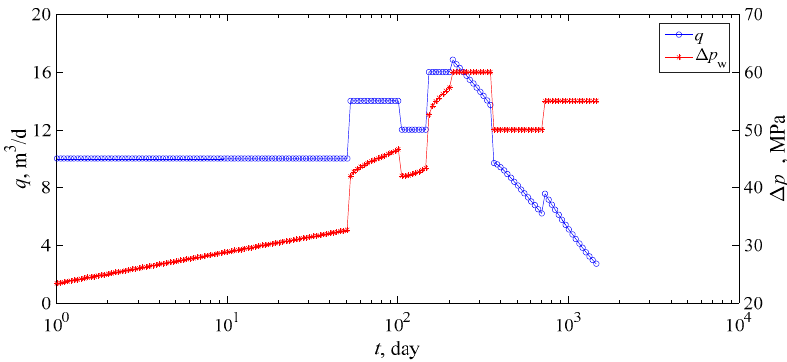
Figure 19. Production data for Case 4 with variable rate and pressure.